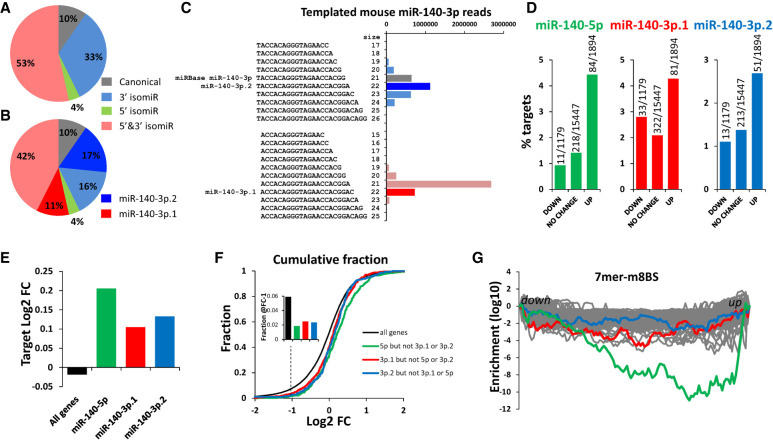
Evidence for functional miR-140-3p.1 and miR-140-3p.2 in mouse cartilage. (A) Pie chart illustrating the fraction of miR-140-3p reads with canonical 5′ and 3′ ends (gray), canonical 5′ and either shorter or longer 3′ (blue), canonical 3′ and either shorter or longer 5′ (green), either shorter or longer 5′, and either shorter or longer 3′ (red). (B) As in (A) with miR-140-3p.1 and miR-140-3p.2 indicated in dark red and dark blue, respectively. (C) Bar chart indicting number of reads that contribute to (B). (D) % of genes that are predicted targets of either a miR-140-5p (green), miR-140-3p.1 (red), or miR-140-3p.2 (blue), in genes whose expression decrease, does not change or increase following KO of miR-140 in mice. (E) Median fold change (FC) of all genes that are predicted targets of either a miR-140-5p (green), miR-140-3p.1 (red), or miR-140-3p.2 (blue) following KO of miR-140 in mice. (F) Cumulative fraction plot of all genes (black), miR-140-5p (green), miR-140-3p.1 (red), or miR-140-3p.2 (blue) predicted targets, for genes ordered from most decreased expression to most increased expression in Mir140-null mice. (Inset) Fraction at a cut-off of log2FC-1. (G) Sylamer analysis for Mir140-null mice; the 100 most enriched 7mers are shown with 7m8 binding sites for miR-140-5p (green), miR-140-3p.1 (red), and miR-140-3p.2 (blue) highlighted.